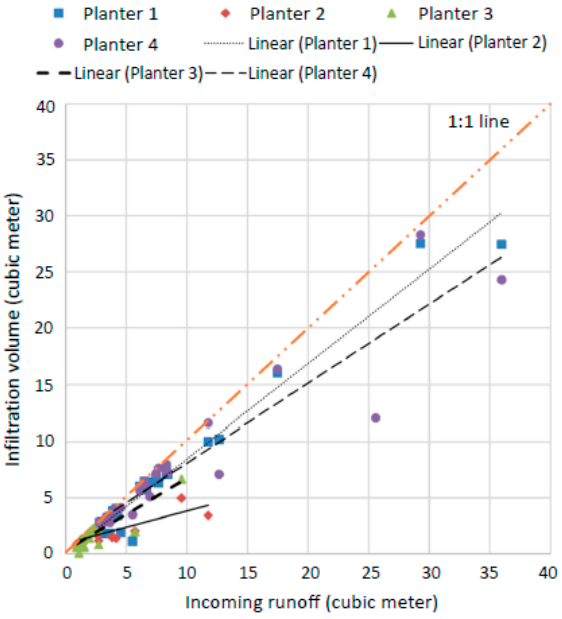
Figure 4. The relation between incoming runoff and infiltration volumes for all four planters.